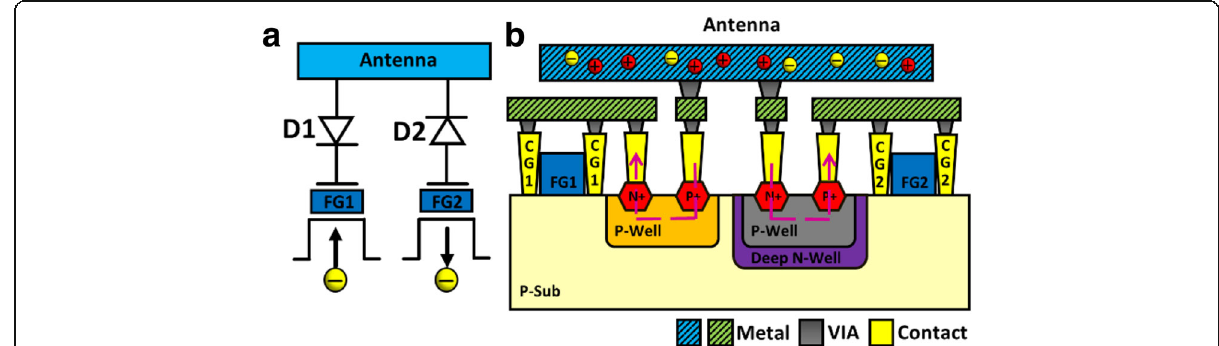
Fig. 4 a Charge splitting in situ recorder with two separate floating gates by connecting to a forward diode (D1) and a reverse diode (D2) for detecting electron/ion charging, respectively. b Cross-sectional illustration of the new charge splitting in situ recorder with on-chip pn diodes, directing the positive and negative charge to the separated coupling gates, CG 1 and CG 2